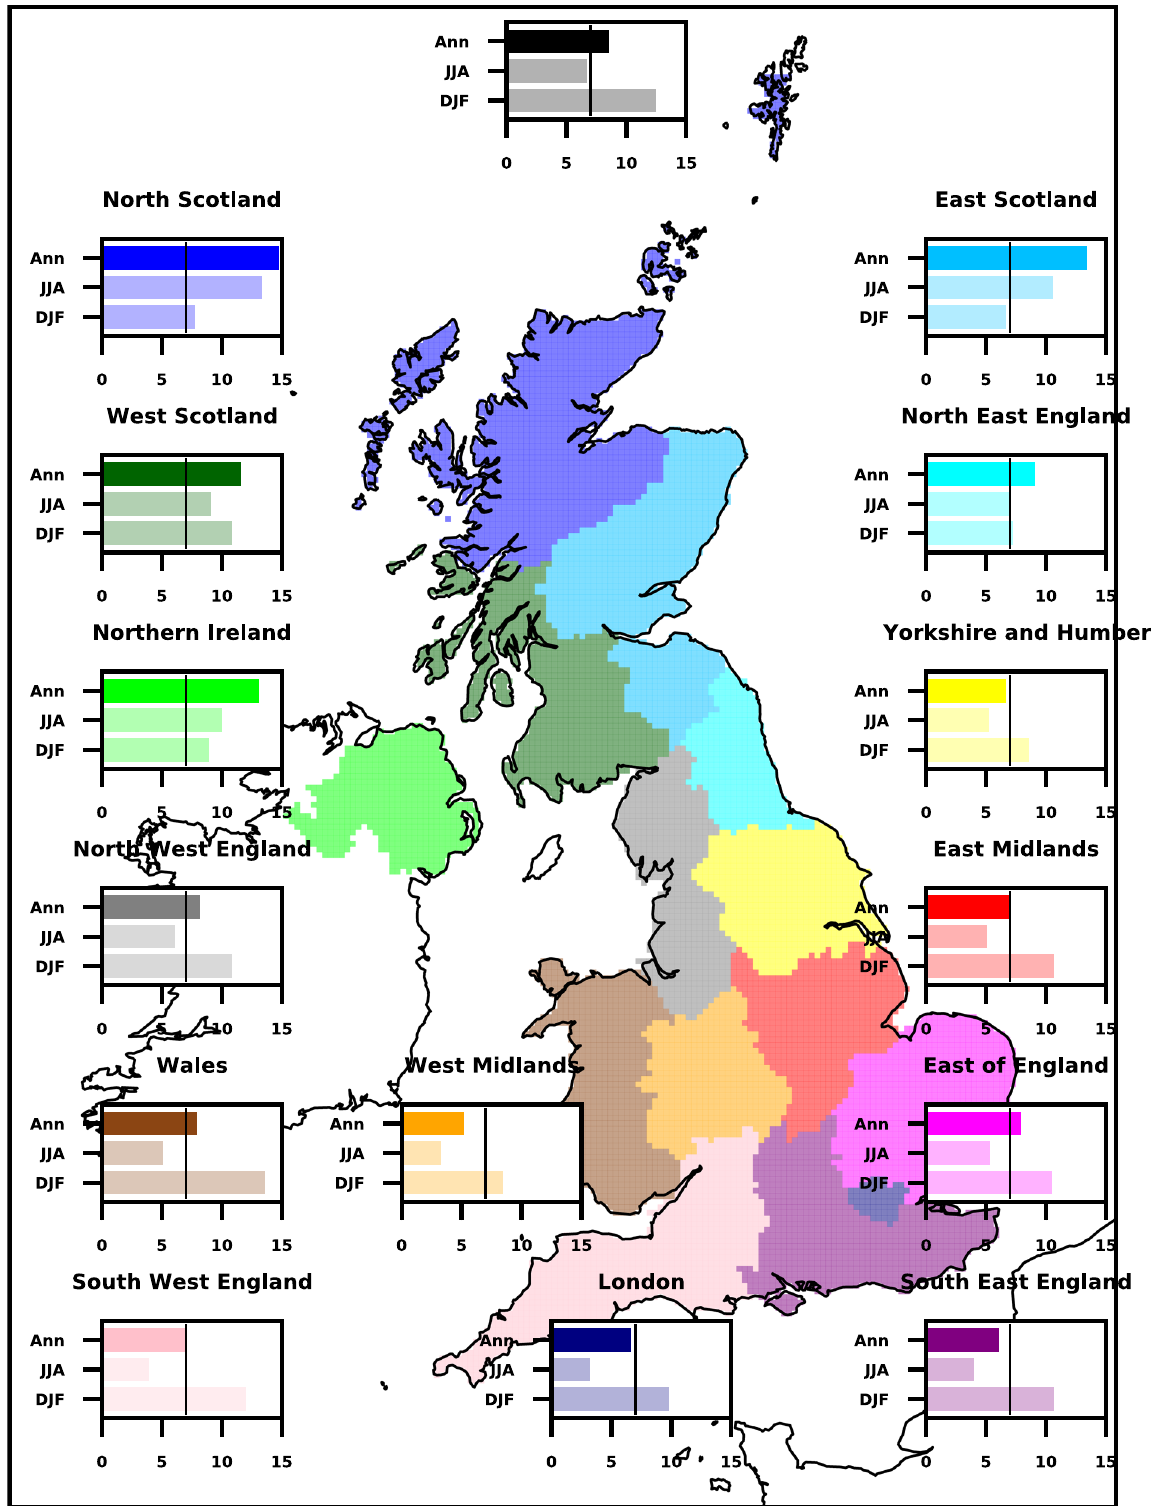
Fig.6|Temperaturescalingofunderlyingchangeinregionalmaximumhourly precipitation. Scaling coef fi cients (%/K) for underlying climate change signal in regional maximum hourly precipitation in the convection-permitting model, for regions of the UK. Values correspond to the gradient of a linear trend line fi tted to smoothed yearly (annual, Ann) [or seasonal (December – January – February DJF or